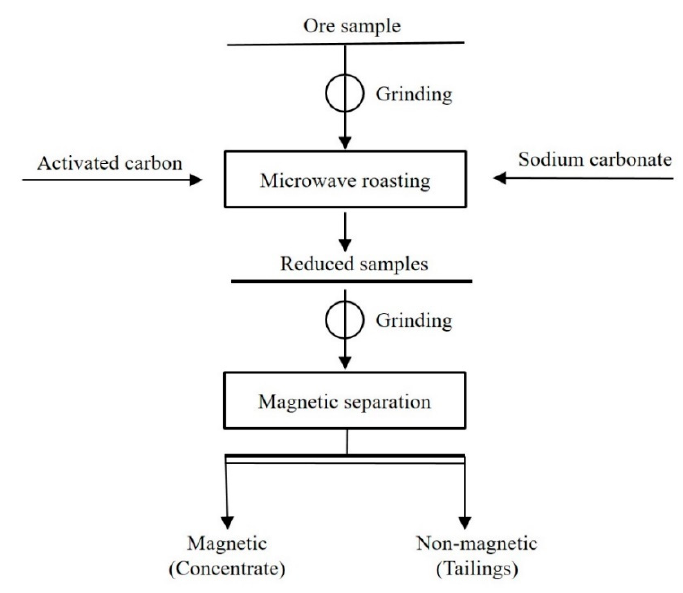
Figure 1. Reductive microwave roasting (RMR) and magnetic separation (MS) processes.